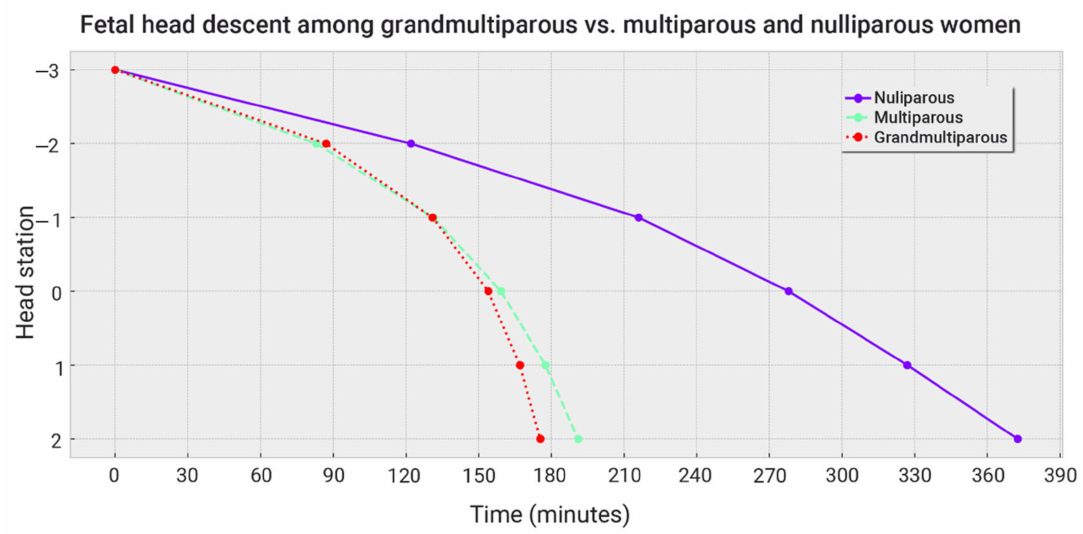
Figure 2. The slightly faster head descent of GMPs compared to